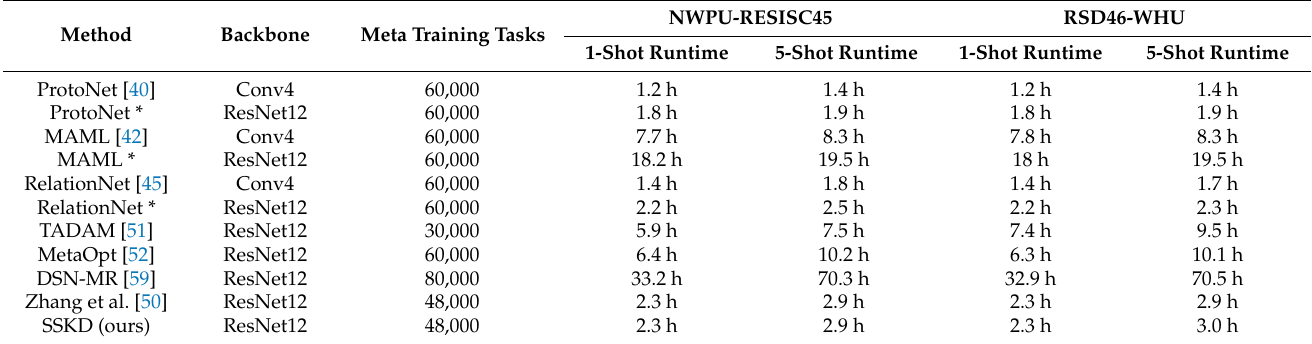
Table 5. Meta-training runtime comparison of methods on NWPU-RESISC45 and RSD46-WHU datasets, under 5-way 1-shot and 5-way 5-shot classification scenarios. * represents the backbone of the original method is replaced with Resnet-12.